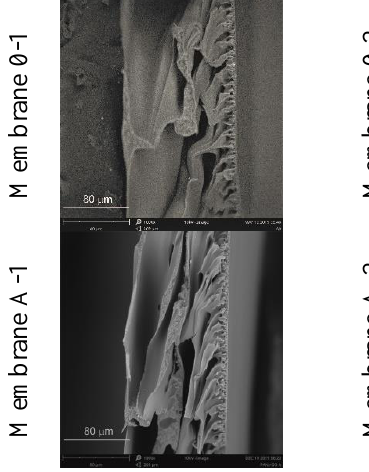
Figure2. ImagesofmembranepurePANmembrane(membrane0)andrGO / PANcompositemembranes Figure 2. Images of membrane pure PAN membrane (membrane 0) and rGO/PAN composite (membranes A-H). membranes (membranes A-H).